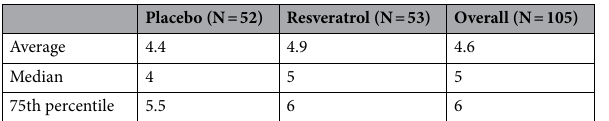
Table 4. Time (days) from symptom onset to delivery of treatment packets (start of